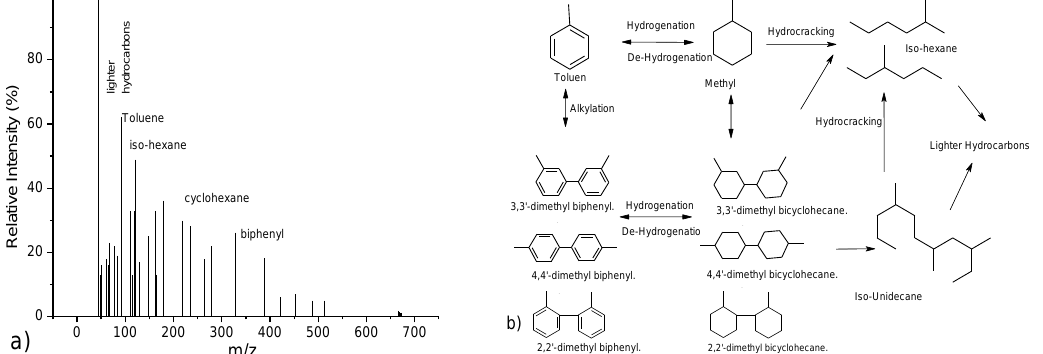
Figure 7. ( a ) Product distribution for hydro-isomerisation of Toluene using Pt/ H -β at T = 240 °C, P = 5.0 MPa, LHSV = 1 h –1 and GHSV = 1180 mln/(g.cat).h and ( b ) Proposed reaction scheme for dearomatisation of Toluene.